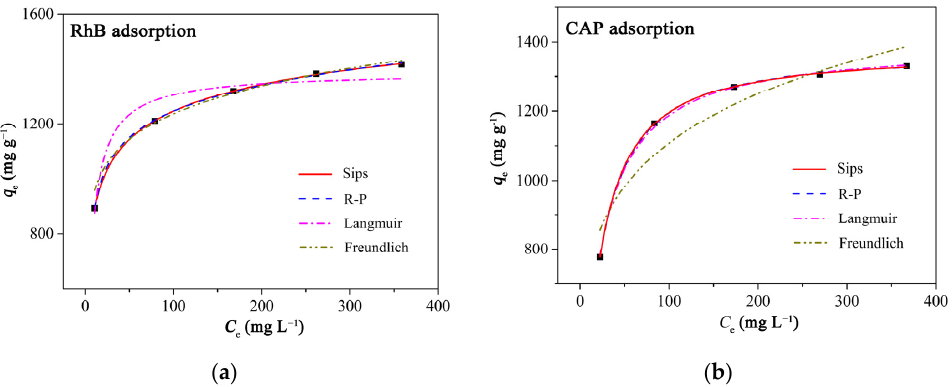
Figure 6. The relationships between the equilibrium adsorption capacities of ( a ) RhB and ( b ) CAP on PCAC and the initial adsorbate concentrations fit the Langmuir, Freundlich, Temkin, R-P, and Sips isotherm models, respectively. Conditions: adsorbent, 20 mg; solution volume, 200 mL; initial concen- tration, 100–500 mg L − 1 ; Temperature, 30 °C. The pH values of RhB solutions were not adjusted. Table 1. Parameters of adsorption isothermal models for RhB and CAP adsorption on PCAC.